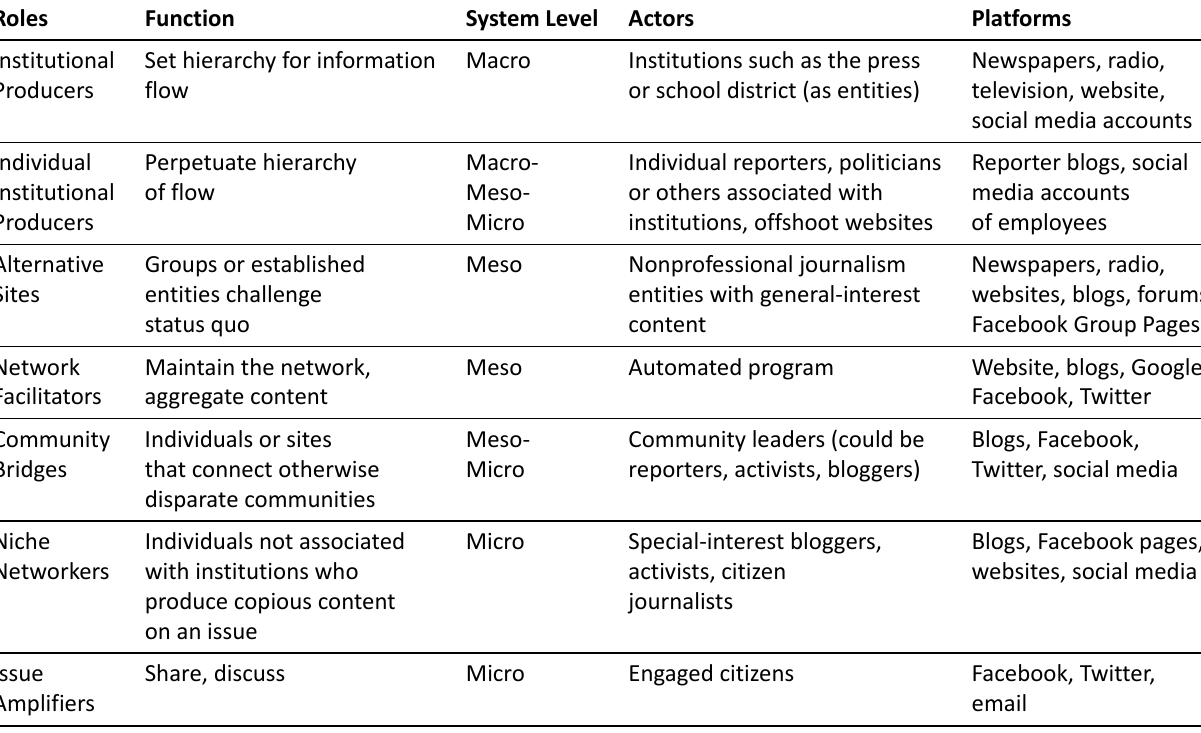
Table 1. Participatory roles in an emergent ecology in local community.